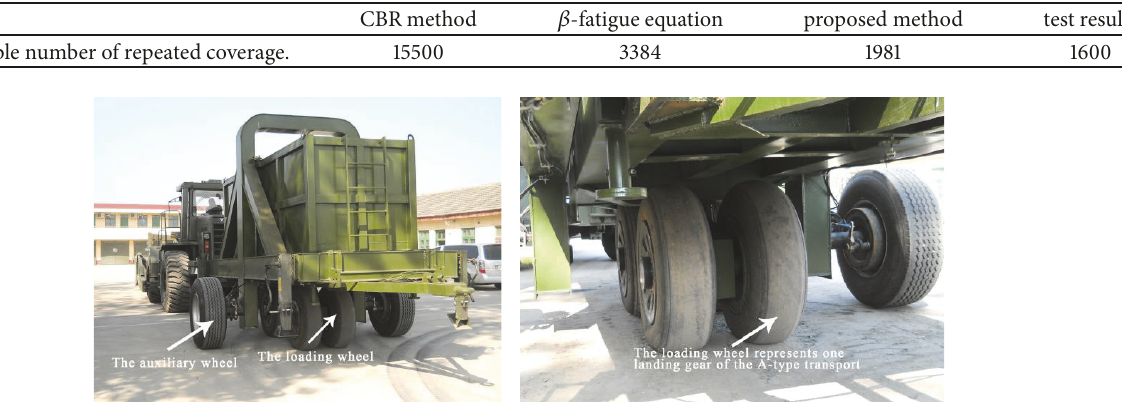
Figure 10: Photograph of loading vehicle.